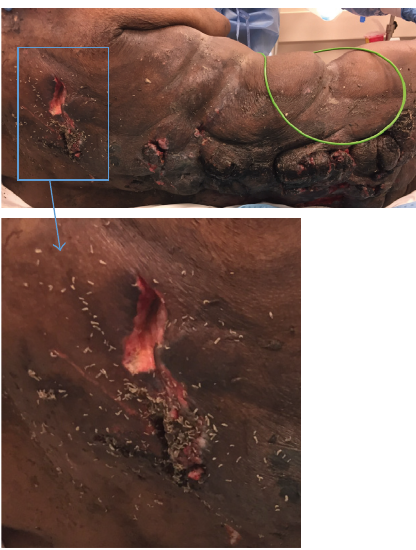
Figure 1: Our patient presented with neglected back wounds infested with maggots that ultimately may have been the source of Ignatzschineria indica in the bloodstream.